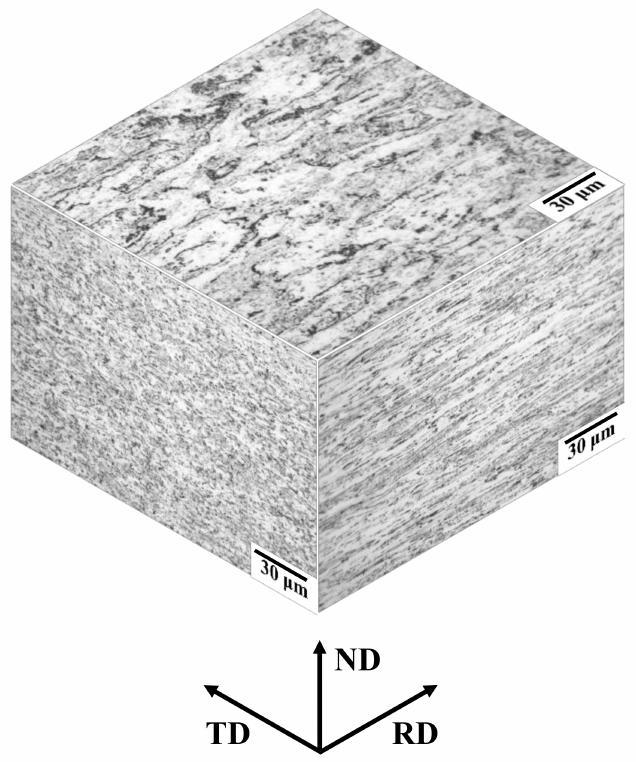
Figure 9. Three-dimensional microstructure of as-cold-rolled